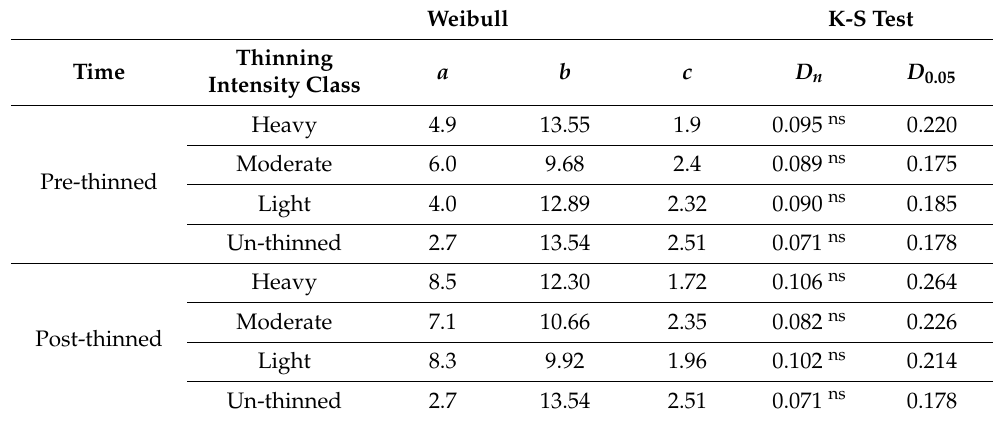
Table 2. Weibull parameter estimates and Kolmogorov-Smirnov (K-S) test results before and after thinning of Honduras mahogany in the Guanmiao Farm in Guanmiao, Taiwan (ns: non-significant in